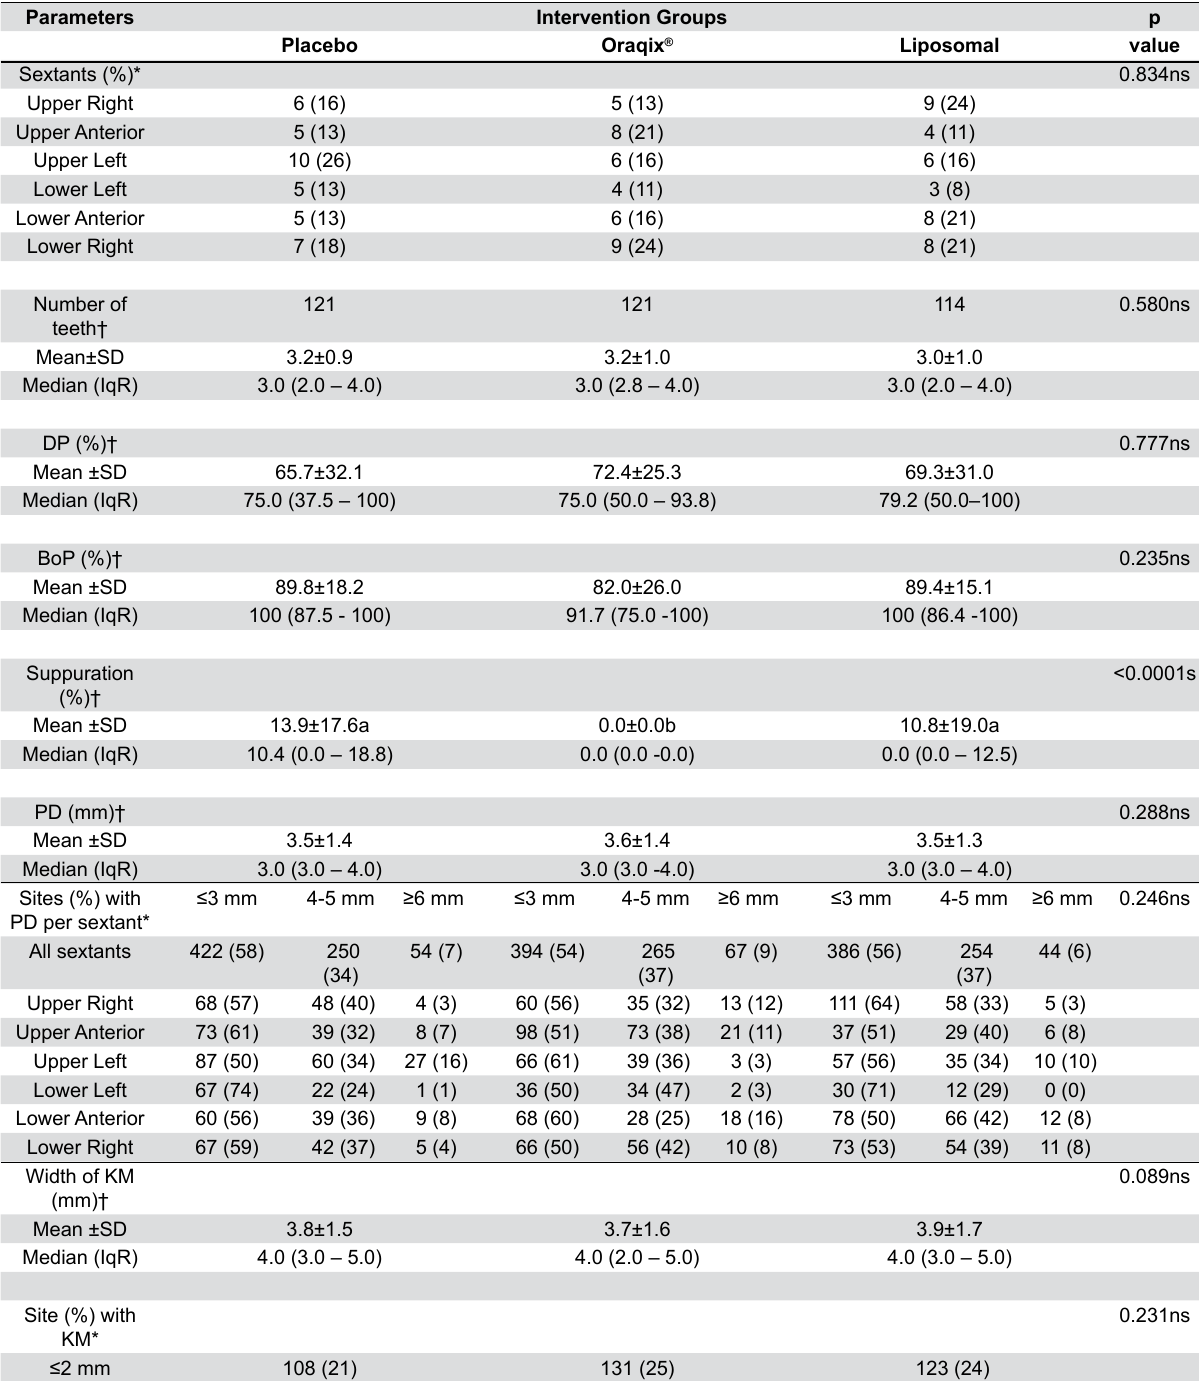
Table 1- Distribution of sextants, number of teeth and periodontal clinical parameters: Dental plaque (DP); Bleeding on Probing (BoP); Suppuration; Probing depth (PD) and width of keratinized mucosa (KM)